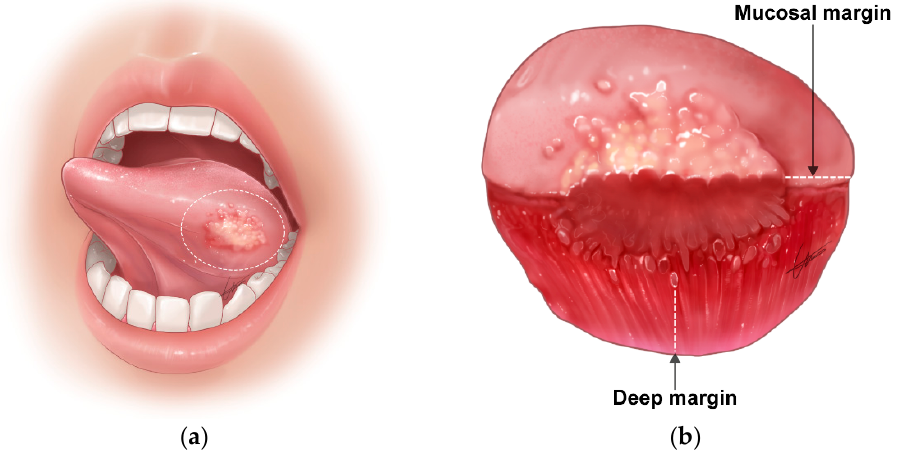
Figure 2. Resection of oral cancer with irregular three-dimensional growth. ( a ) Setting of appropriate safety margin in oral cancer surgery. Dotted line indicates mucosal safety margin; ( b ) surgical specimen that includes primary tumor and normal surrounding tissues. The resection margin includes mucosal and deep margins.